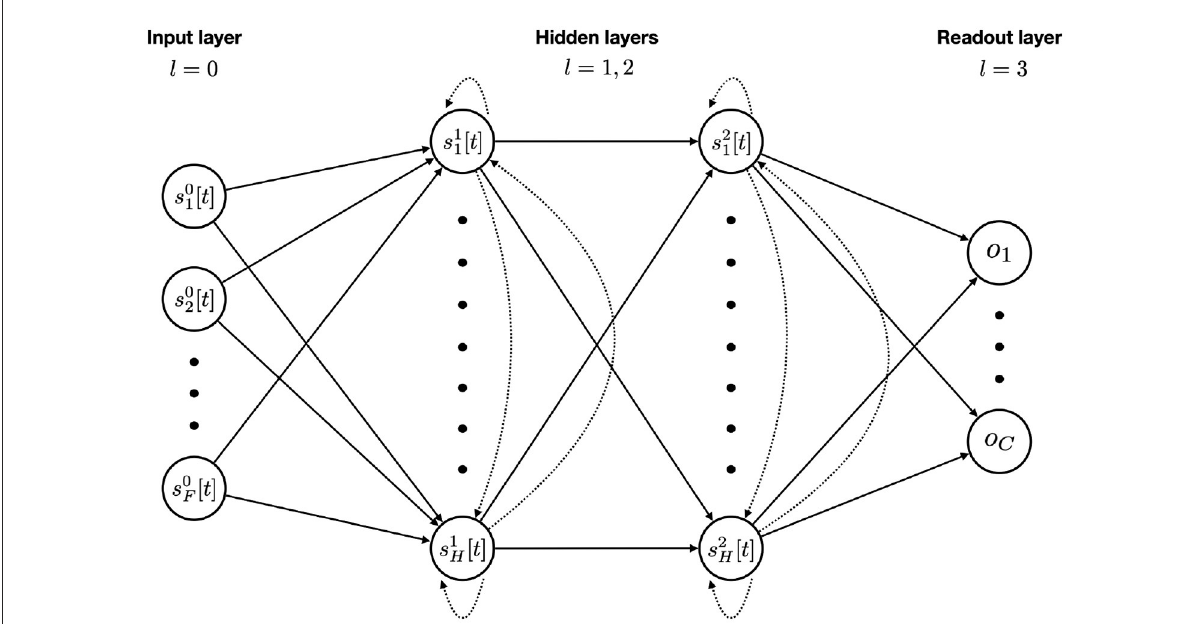
FIGURE2 SNN model architecture with F input features, two recurrent layers with H hidden units each, and a final readout layer for the C classes. Feedforward and recurrent connections are represented with solid and dotted arrows respectively. An input unit is simply the value of that feature at the given time step. Each hidden unit integrates the incoming stimuli from feedforward and recurrent connections at time step t with Equation (12). The membrane potential is updated and a spike is emitted if threshold is reached. A readout unit integrates the purely feedforward incoming stimuli, updates its membrane potential (without spiking) and accumulates it over time using the softmax function. After passing the whole sequence through the network, the outputs then go into a cross-entropy loss function. Back-Propagation is made possible via the use of a boxcar surrogate